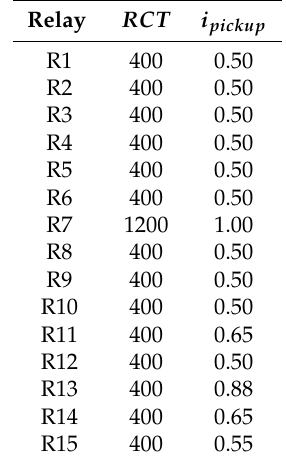
Table 3. RCT and i pickup for each relay.